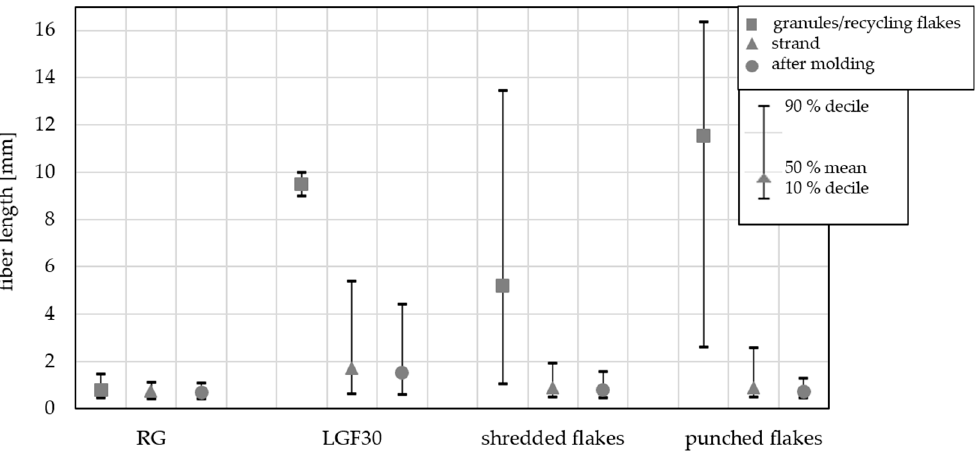
Figure 6. Comparison of fiber length degradation during injection molding between the two comminution methods (shredded flakes and punched flakes) and the reference materials (RG and LGF30); shown are the deciles 90% and 10% as well as the mean value with 50% of the fiber lengths per sample.